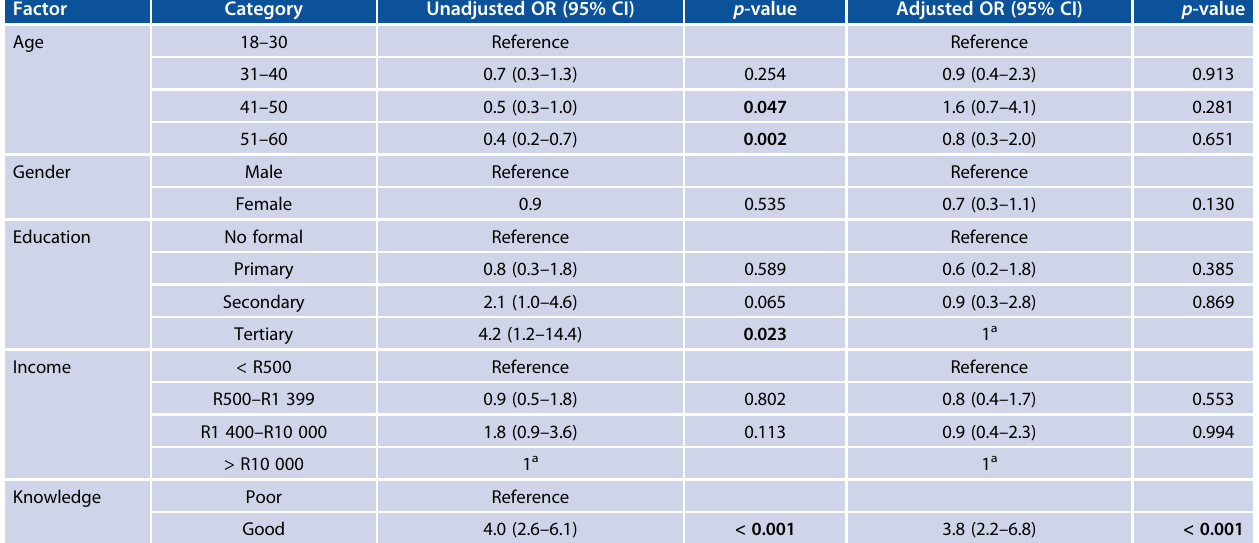
Table 5: Sociodemographic characteristics associated with good attitudes towards antibiotic use amongst patients at Prince Mshiyeni Memorial Hospital 2017